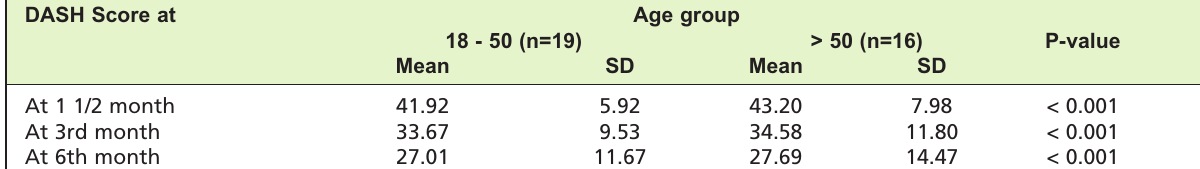
Mean DASH score vs age of patient Table VII: